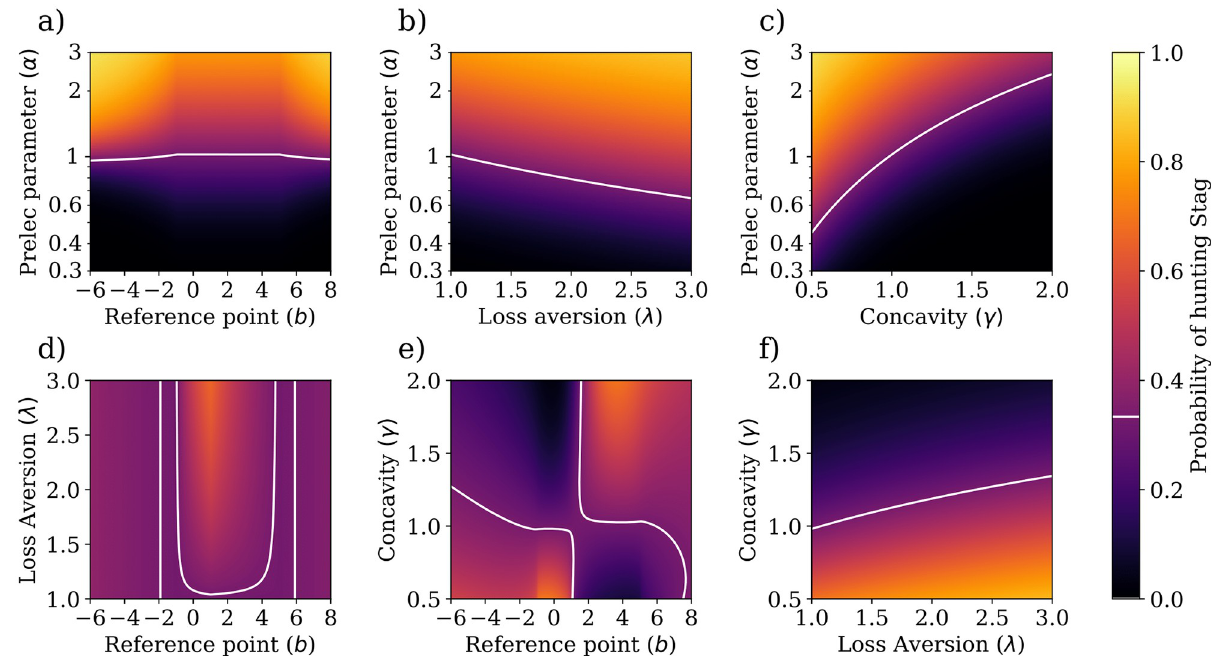
Fig 3. Probability of hunting stags in a normal-form stag hunt game. Cumulative prospect theory can explain a wide range of coordinating behaviors in a simple game such as the stag hunt, depending on how probabilities are perceived and how outcomes are framed. The panels show the probability of choosing Stag in the stag hunt normal-form game, for pairs of parameters of prospect theory—i.e., reference point b , Prelec parameter α , loss aversion λ , and utility concavity γ . For each pair of parameters, the remaining ones were left at default values: b = 0, α = 1, λ = 1, and γ = 1. Lighter colors indicate higher probability of hunting stag. White line represents the mixed Nash equilibrium of